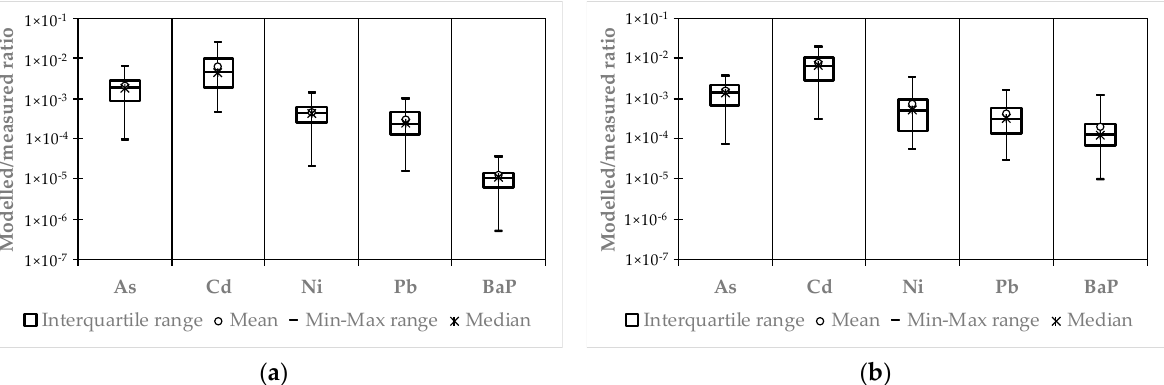
Figure 6. Distributions of the relative contributions (modelled/measured ratio) of the plant emissions to the daily average concentrations of toxic elements (As, Cd, Ni, Pb) and benzo(a)pyrene (BaP) in the cold ( a ) and warm season ( b ) at site R1.